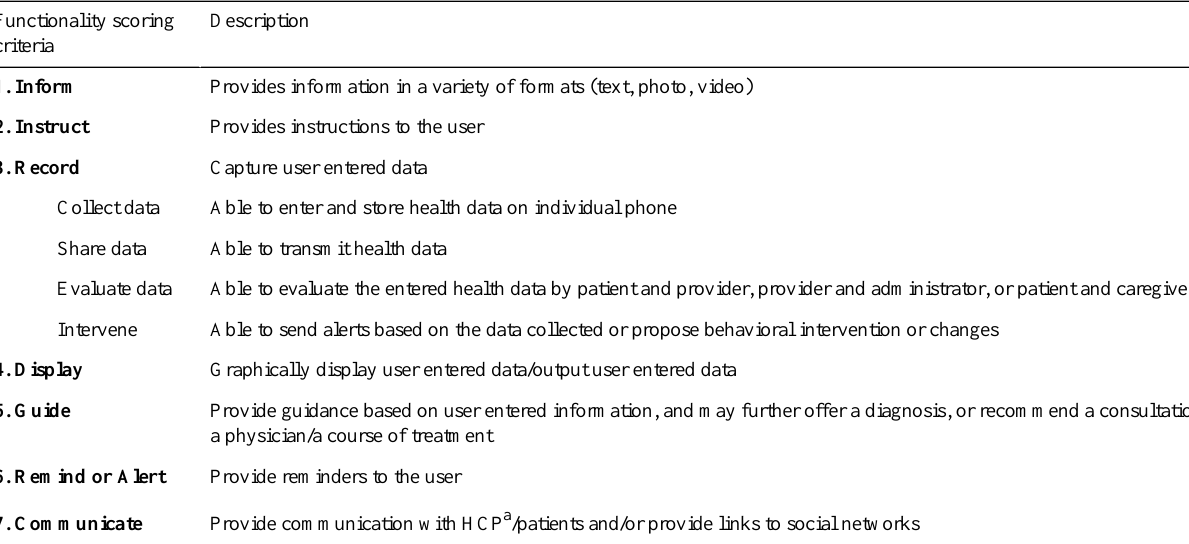
Table 1. IMS Institute for Healthcare Informatics functionality scoring